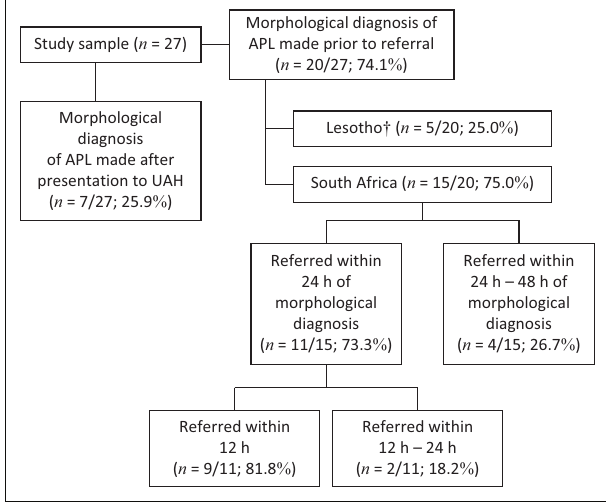
FIGURE 2: An illustration of the time taken for referral to Universitas Academic Hospital after a morphological diagnosis of acute promyelocytic leukaemia was made.